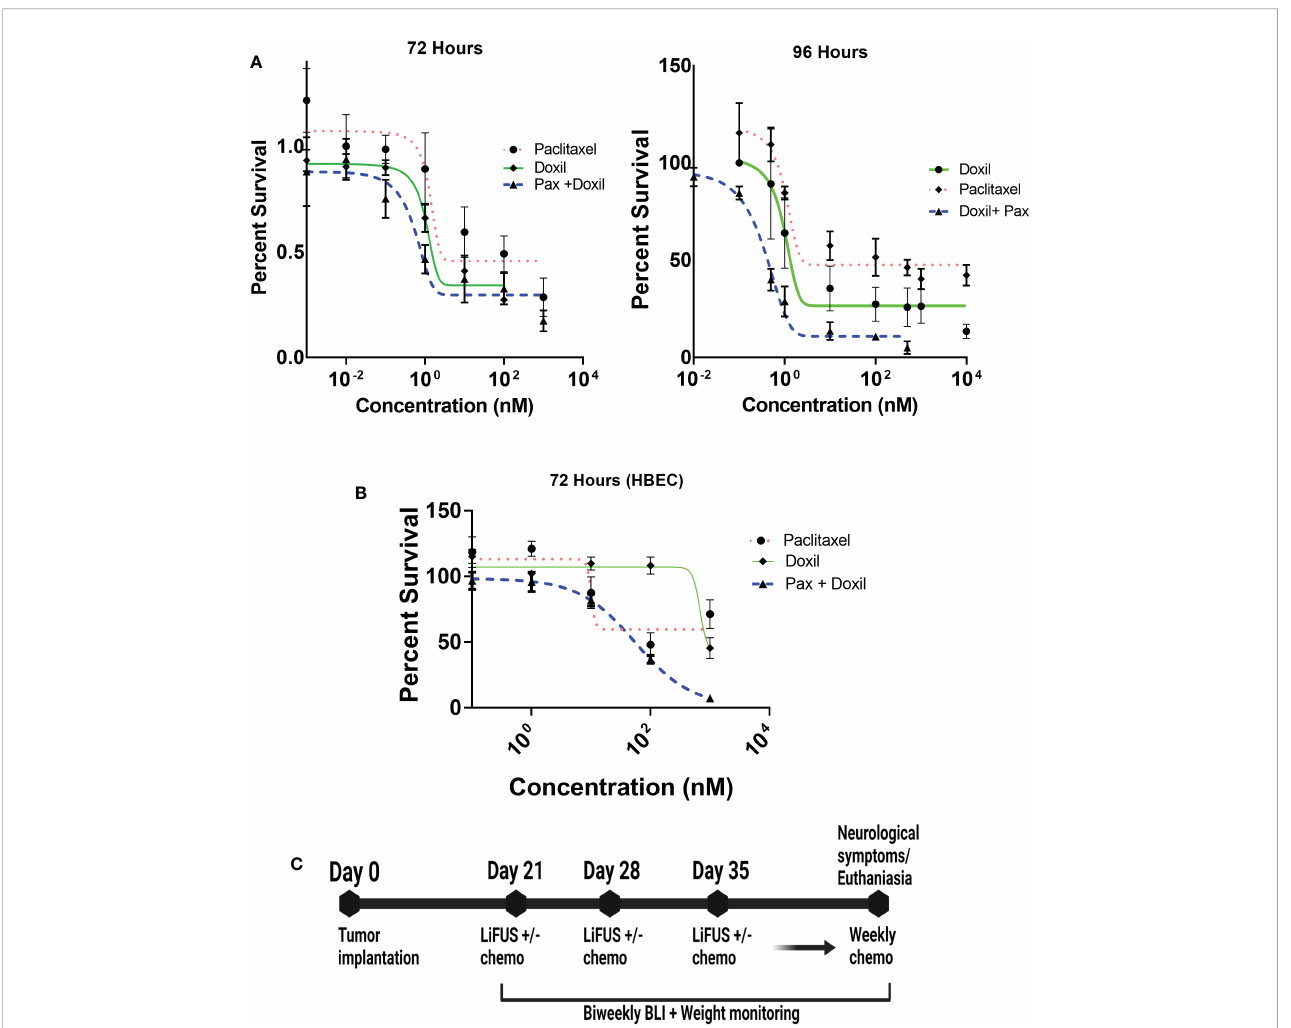
FIGURE 3 Treatment strategy for LIFU+ combinatorial chemotherapy. (A) Paclitaxel+ Doxil have additive action against MDA-MB-231Br cells (IC50 1.8± 0.91nM) (B) Paclitaxel+ Doxil are safe at the administered concentrations to HBEC cells. (IC50 56 ± 1.7nM) (C) All animals were treated with LIFU or chemotherapy for one session, every week for three weeks, after which weekly treatment with chemotherapy was continued until collection.